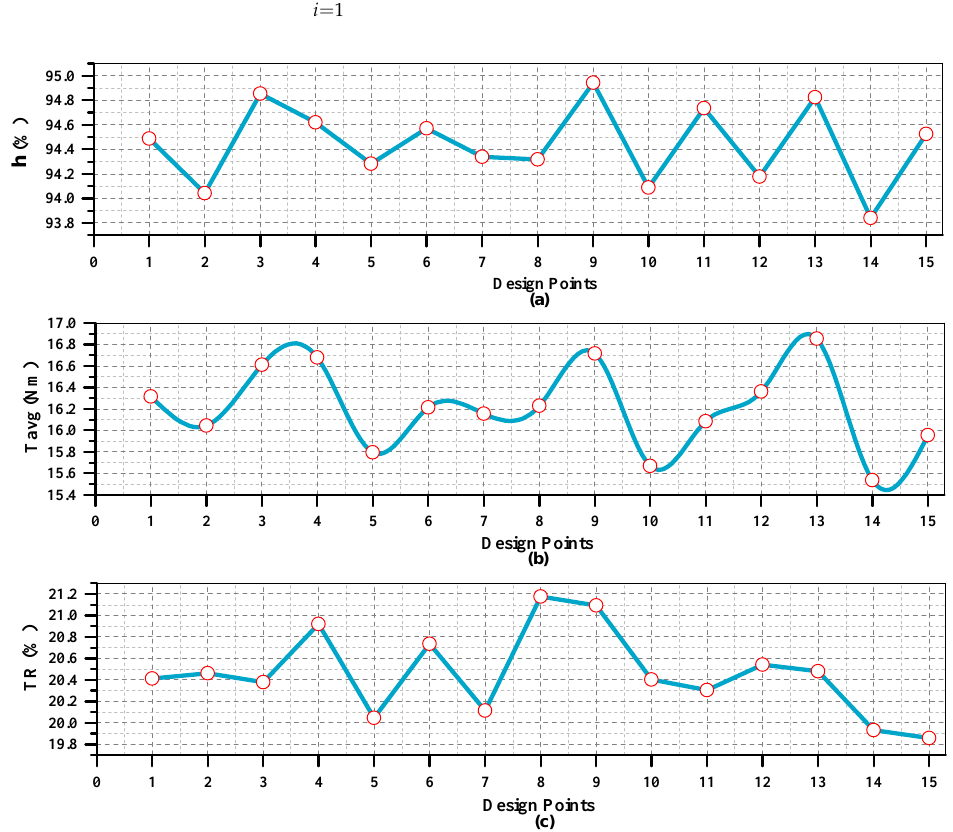
Figure 8. Output parameter with design points ( a ) η with design points ( b ) T avg with design points ( c ) TR with design